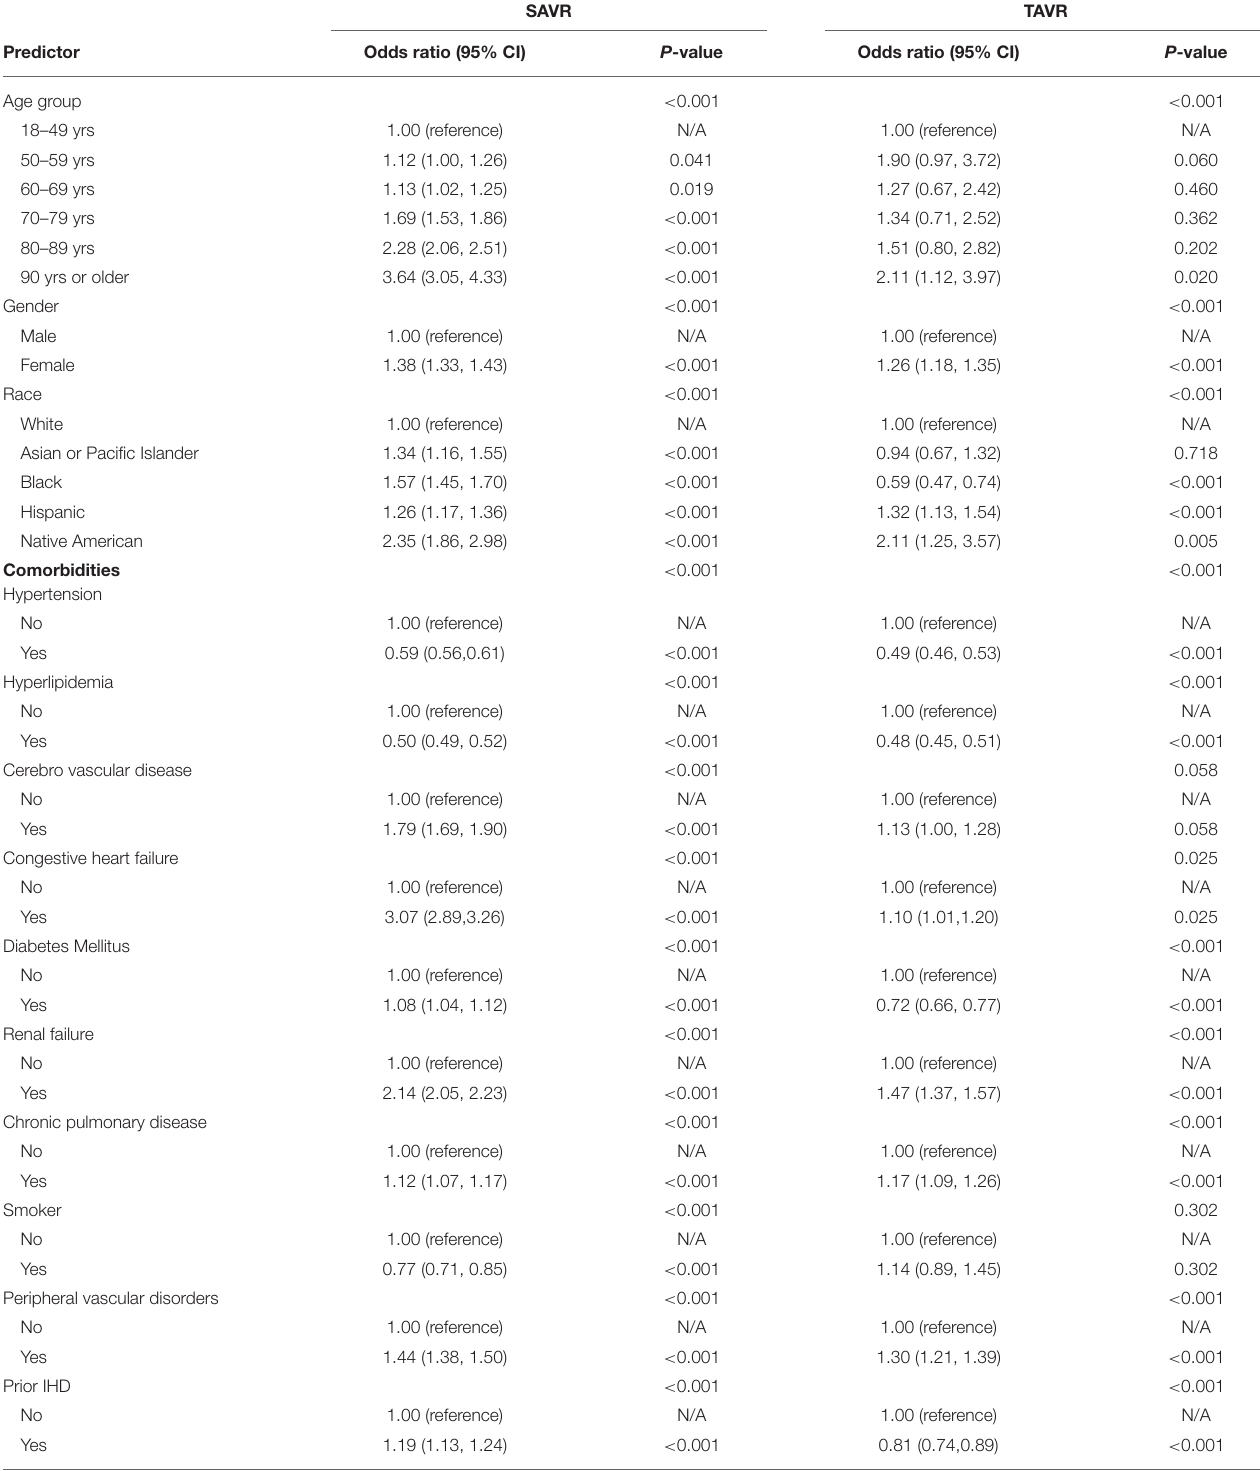
TABLE 3 | Multivariate analysis for predictors of mortality from 2011 to 2017 in SAVR and TAVR